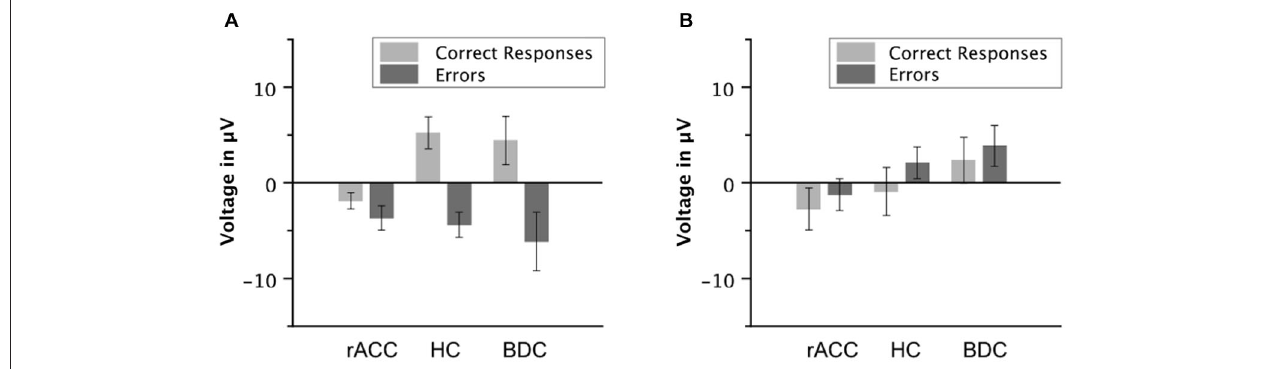
Group), in healthy controls (HC Group), and in patients with brain lesions outside the frontal lobes (BDC Group). µ V = microvolt; error bars represent standard errors of the mean.